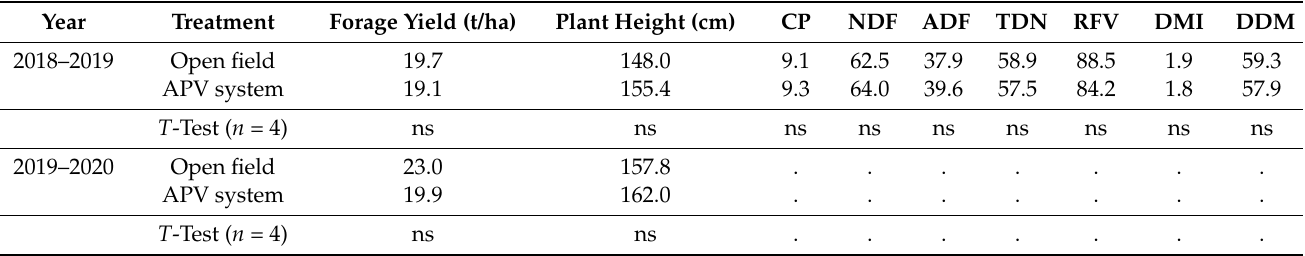
Table 4. Evaluation of silage quality for rye on a dry basis between the agro-photovoltaic system and the open field over two years.